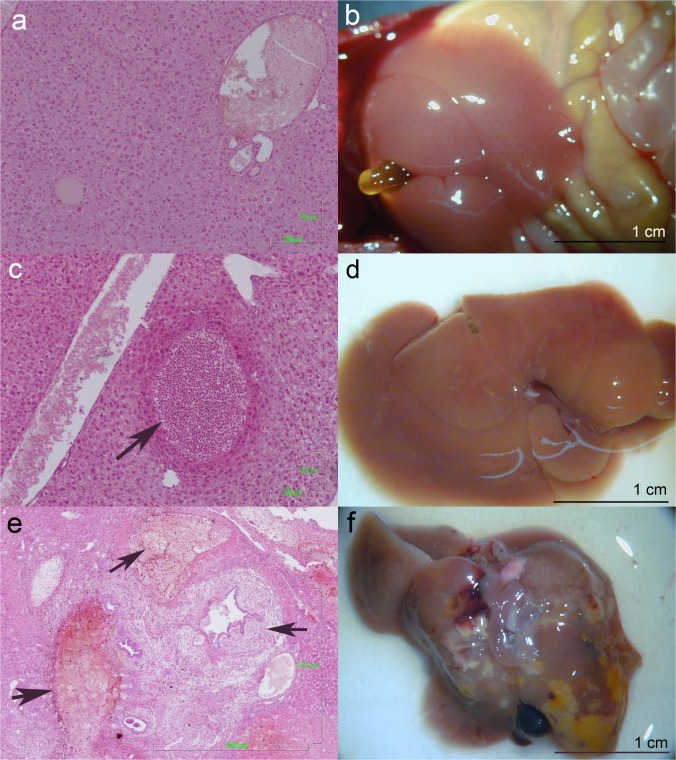
Macro and microscopic hepatic lesion of mice infected orally with 7 metacercariae of F. hepatica.(A, B) Uninfected control. Micrography section of a migration tract with infiltrates (C) and the liver with whitish tracts and spots in the parenchyma (D) at 7 days p.i (t7). Liver parenchyma with extensive areas of necrosis, fibrosis, cholangitis and granulomas with infiltrates (E) and severe macroscopic damage (F) at 21 days p.i (t21).